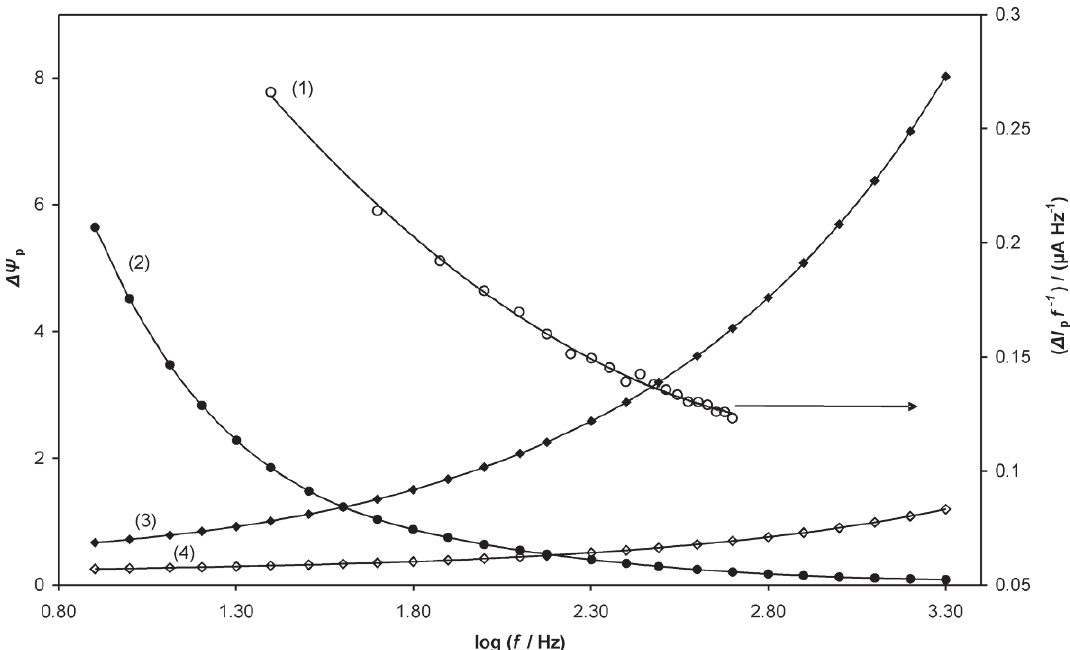
Figure 3. Experimental results (curve 1, right axis). Logarithmic dependence of the ratio Δ I in citrate buffer at pH 2.5 at accumulation time 10s, initial potential 0 V. The conditions of the experiments were amplitude E and step potential Δ E = 15 mV. Theoretical results (left axis). Logarithmic dependence of the dimensionless net peak current, ΔΨ the SW frequency for the hydrogen evolution surface catalytic mechanism (Eqs. 1 and 2) (curve 2) and adsorptive irreversible reductive mechanism (Eqs. 3 and 4) (curves 3 and 4). The conditions of the simulations were: (curve 2) pH = 1, log( k 3 and 4) D = 5×10 -6 cm 2 s -1 and log( β ) = 0 (3) and 3 (4). The other conditions are common for both mechanisms: k n = 1. The parameters of the potential modulation were: f = 25 Hz, E